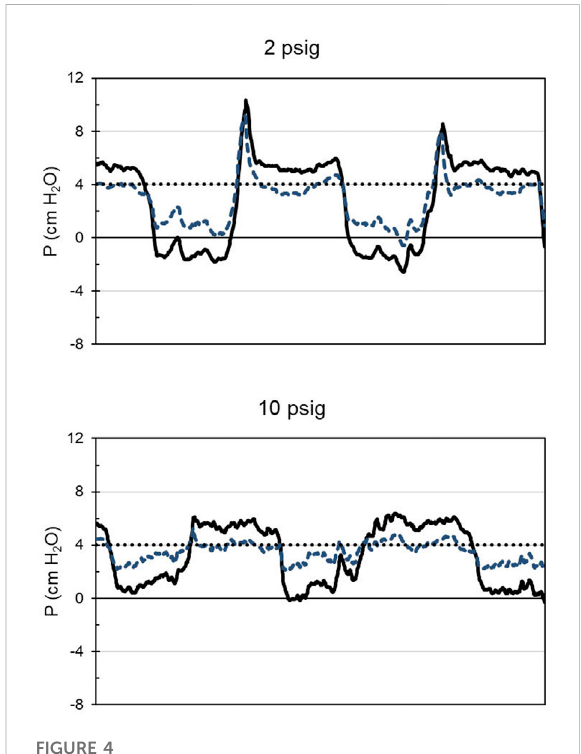
FIGURE 4 A sample of mask and regulator output pressures relative to room pressure as a function of time for 10 s. Participant 16, with the CRU-103 supplied with 2 or 10 psig. Solid black line: mask pressure. Dashed blue line: regulator outlet pressure. Dotted black line: nominal safety pressure. Mask pressures below safety pressure represent inspiration, and those above, expiration. Note pressure spikes at the start of expiration when the regulator inlet pressure is 2